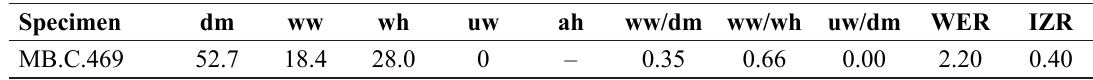
Table 3. Conch dimensions and ratios of Epitornoceras mithracoides (Frech, 1888), lectotype